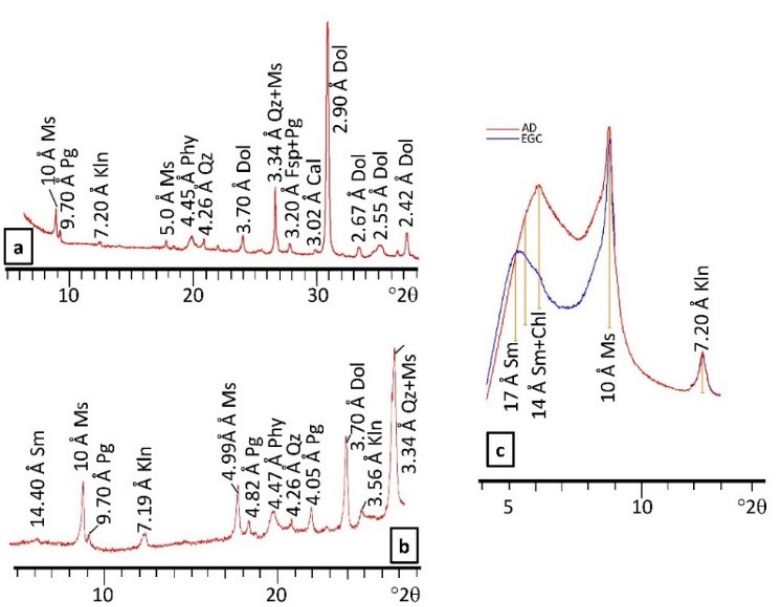
Figure 4. XRD diagrams of the carbonate sediments of the trench. ( a ) Total powder diagram. ( b ) Diffractogram of oriented aggregate (<2 μ m fraction). ( c ) Diffractogram of oriented aggregate (<0.2